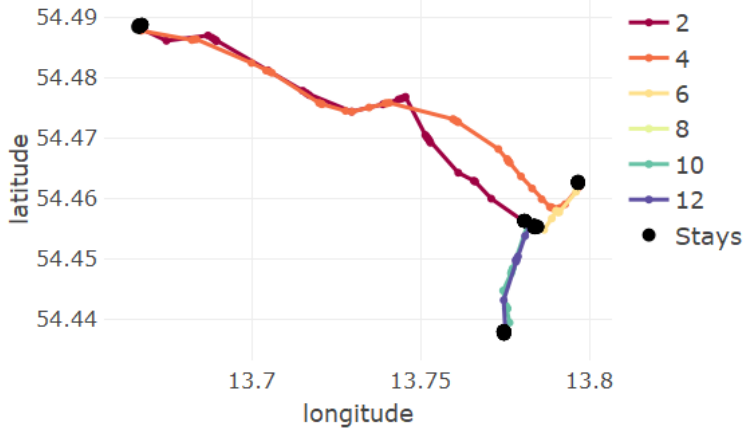
Figure 2. Travel trajectory showing the sequence of stay/move events. All stays are shown as black discs, and each move event shown as a colored line named with its chronological order. The “stays” make up trajectory events 1, 3, 5, 7, 9, 11, and 13. Note: actual GPS data is displaced and the map background removed for